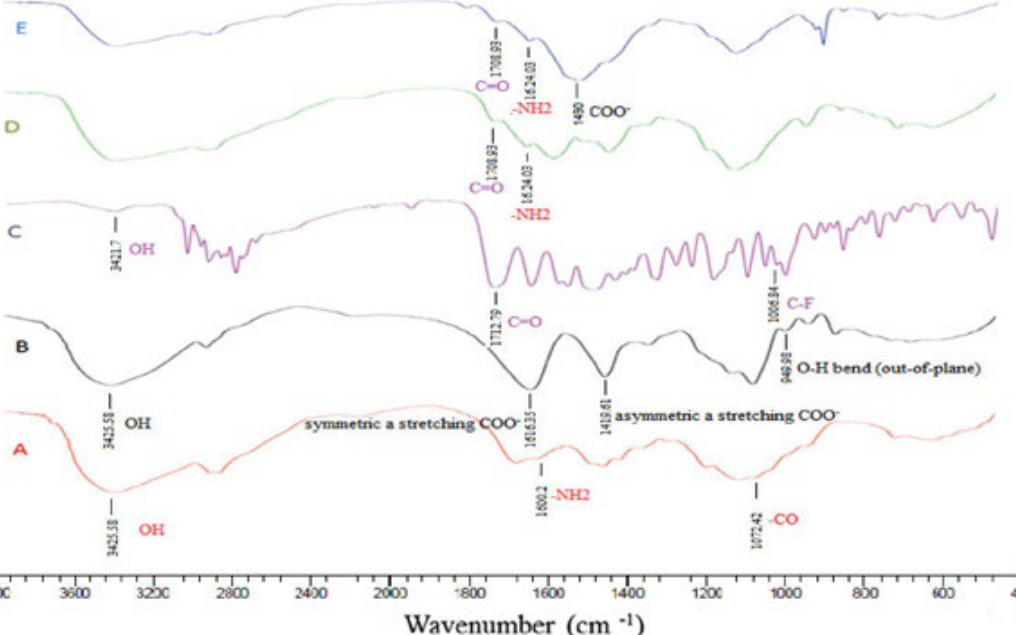
FIGURE 4 - FTIR spectrum: Chitosan (A); Alginate (B); Ofloxacin (C); Chitosan/TPP nanoparticles (D); Chitosan/TPP-Alginate nanoparticles